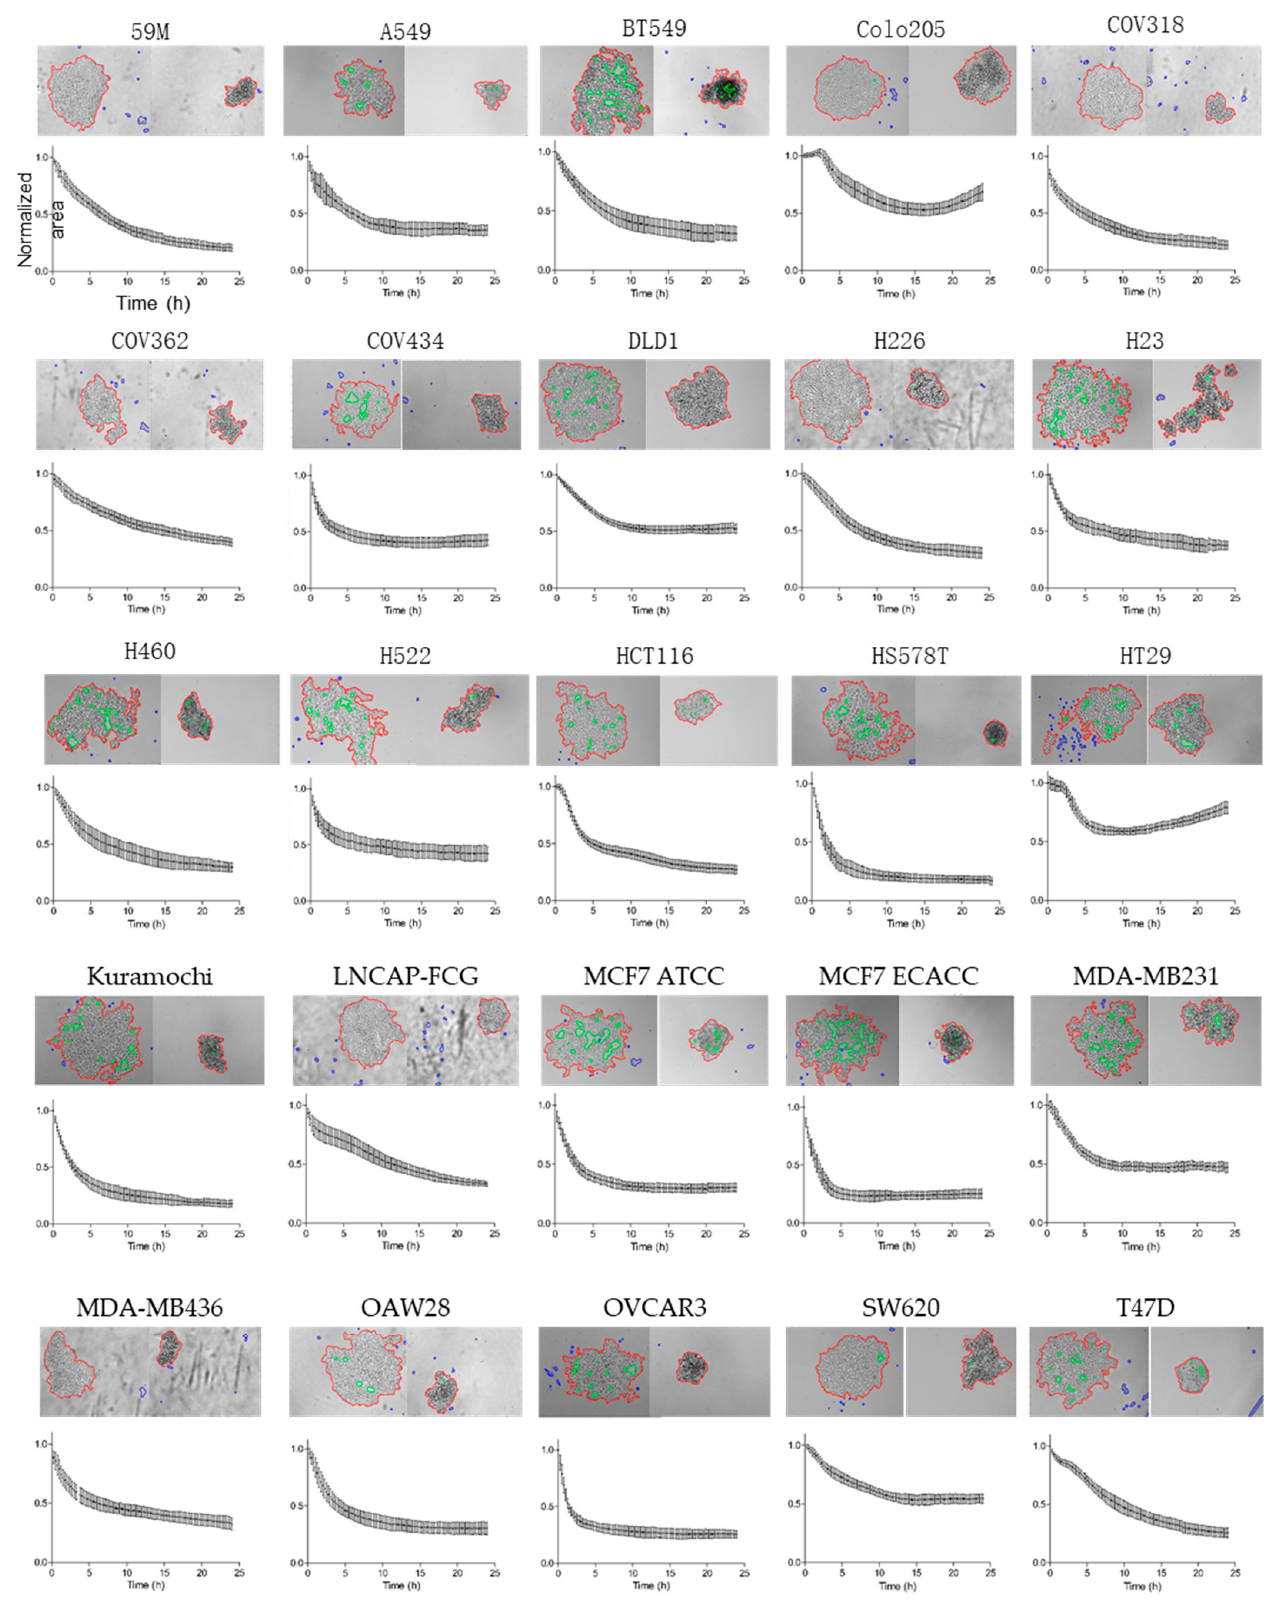
Figure 2. Anchorage-independent aggregation of 25 cancer cell lines. For each cell line, micrographs at time 0 (left) and after 24 h of aggregation (right) (top panel) and the curve of the normalized area (mean values from 28 to 48 replicates and three to five independent experiments) (lower panel) are shown.